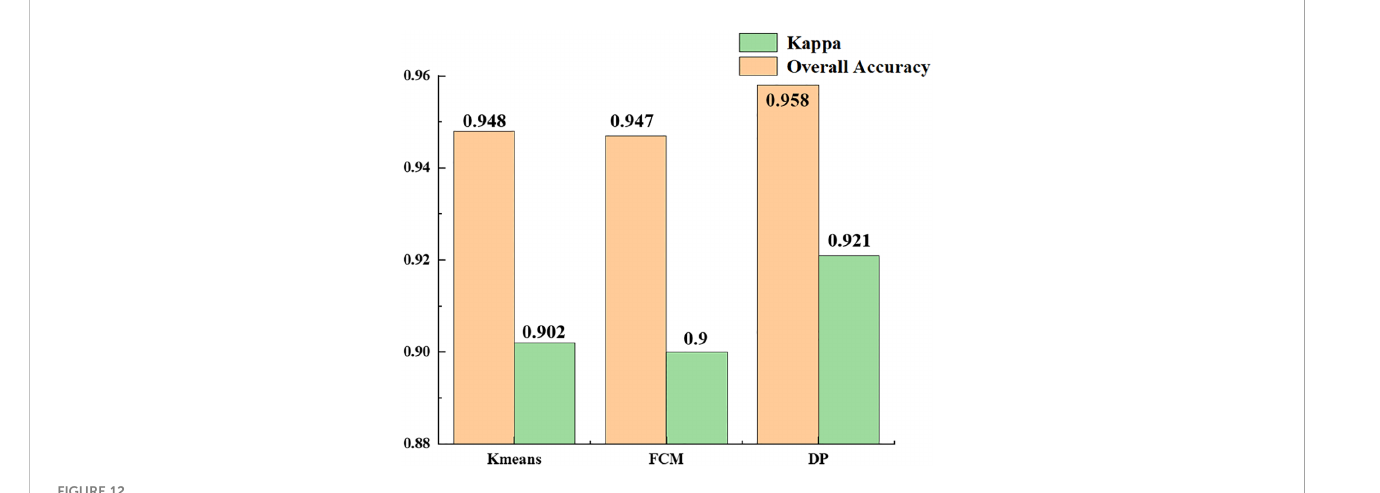
FIGURE 12 Comparison of recognition results of different clustering